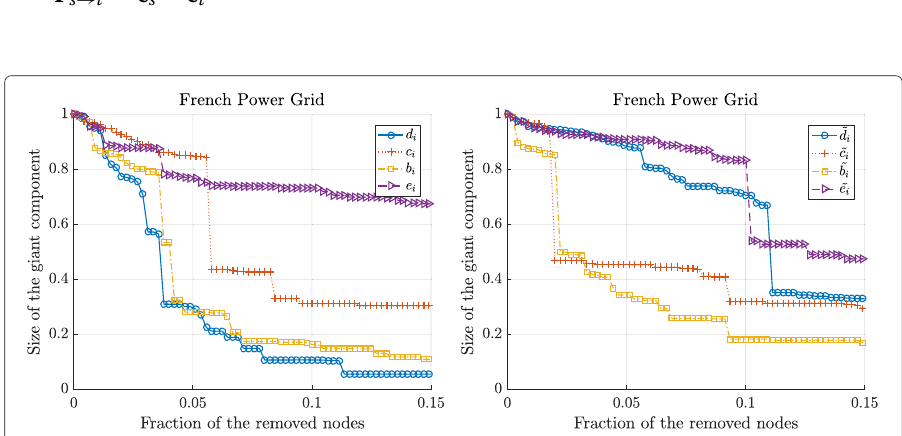
Fig. 7 The normalized size of the giant component in the French power grid versus the removal of nodes according to the standard centrality metrics (left) and the extended centrality metrics (right). Nodes are removed sequentially according to the initial values of the centrality